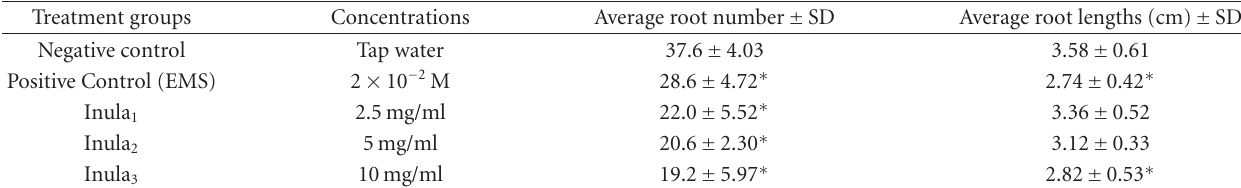
Table 1: The average root numbers and root lengths in controls and treatment concentrations.